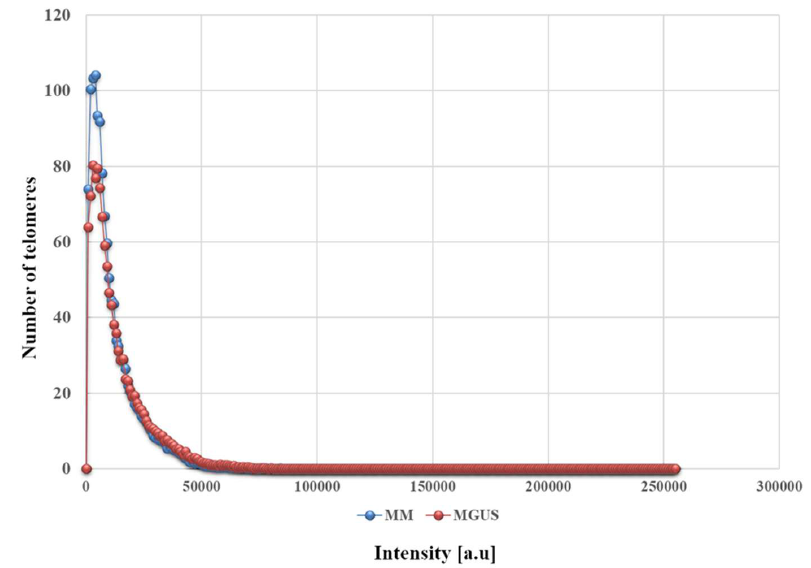
Figure 3. The differing frequency distributions for the intensity of telomeric signals in MGUS (red) and MM (blue). The two stages of the disease are marked by different profiles concerning the signal intensity